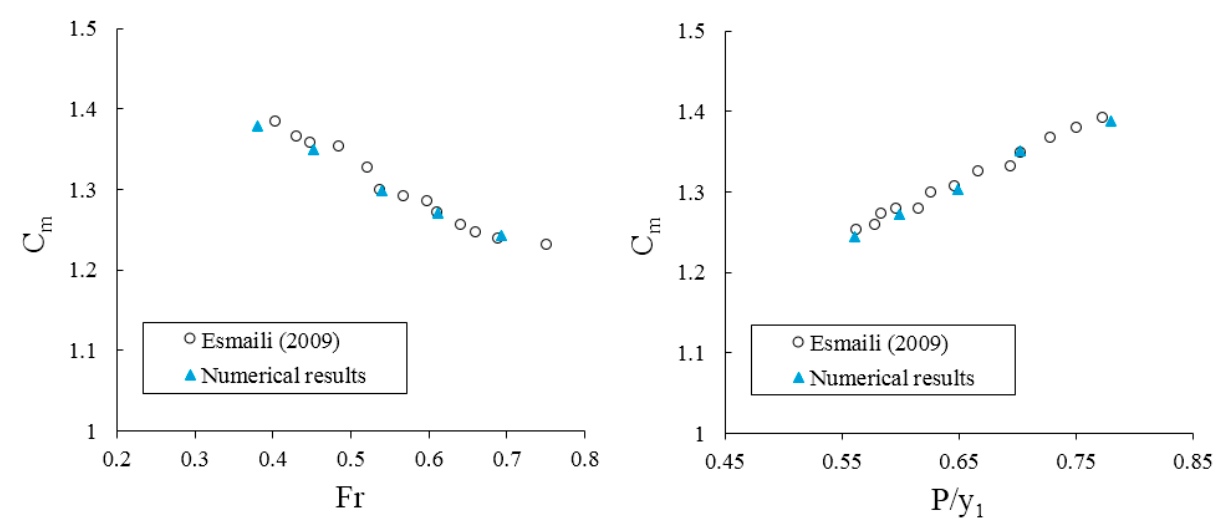
Figure 5. Comparison of the discharge coefficient obtained from numerical simulation and experimental results. The free surface profiles over the triangular labyrinth side weir from numerical and experimental model by Kabiri Samani et al. [12] for the inlet Fr = 0.38 are shown in Figure 6. Comparisons of the experimental and numerical results in accordance with the water free surface profiles on the axis A-A are illustrated in Figure 6.